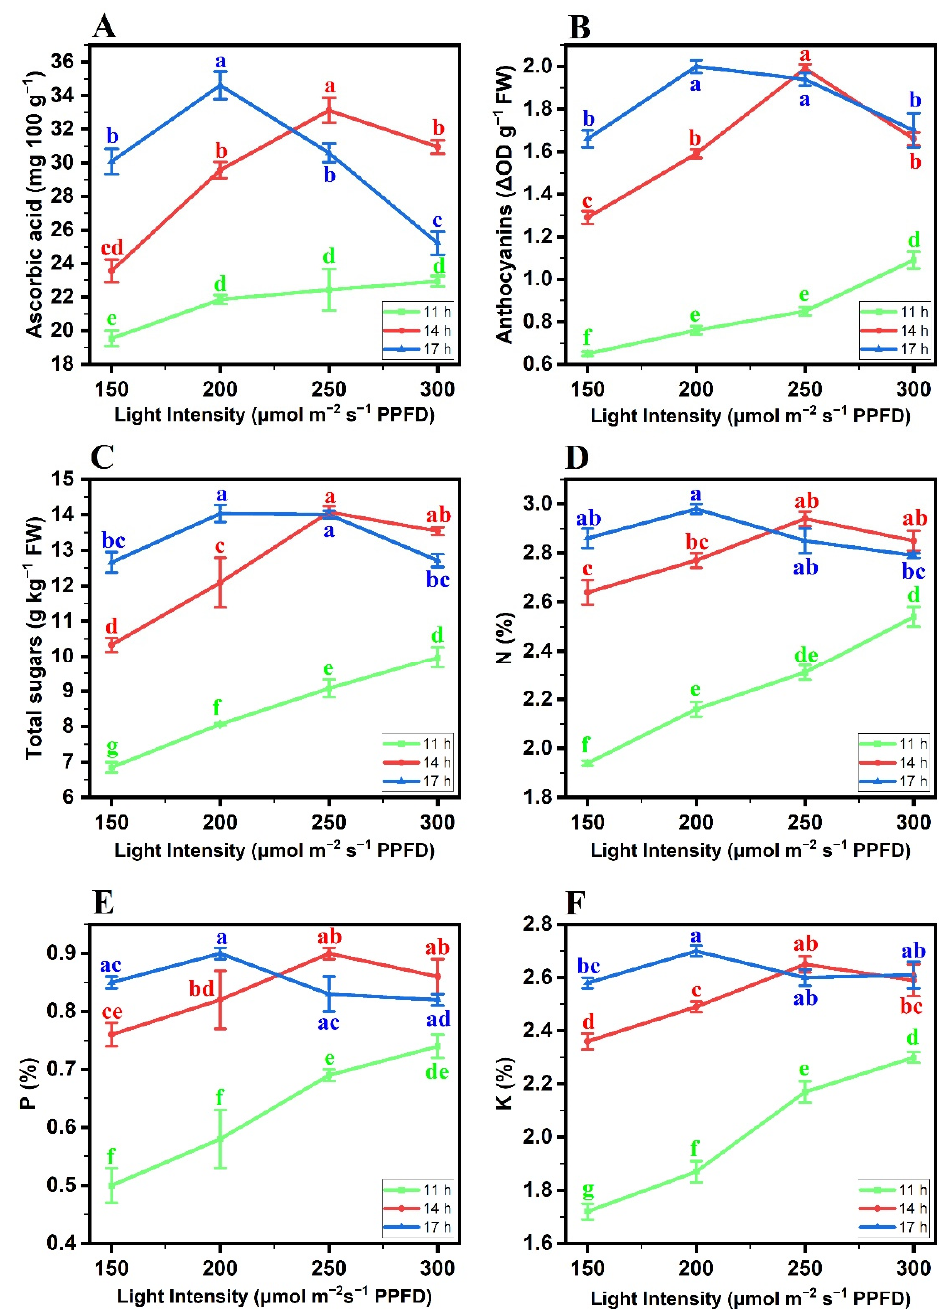
Figure 1. Effects of different photoperiod and light intensity combinations on the biochemical attributes of butterhead lettuce cv. Gustav, including ( A ) ascorbic acid content, ( B ) anthocyanin content, ( C ) total sugar content (TS), ( D ) nitrogen content, ( E ) phosphorous content, and ( F ) potassium content. Each data point is the mean of three independent biological replicates. The Ybar on each data point indicated the standard error within the mean. The statistical analysis is based on a two-factorial completely randomized design. The comparison of the treatment means was performed by the least significance difference (LSD) test for the photoperiod and light intensity. Different letters within each graph indicate significant mean differences, as compared by the LSD ( p ≤ 0.05).